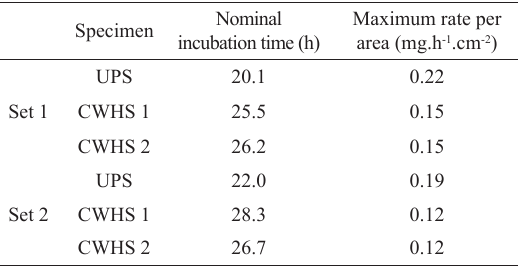
Table 2: Nominal incubation time and maximum erosion rate per